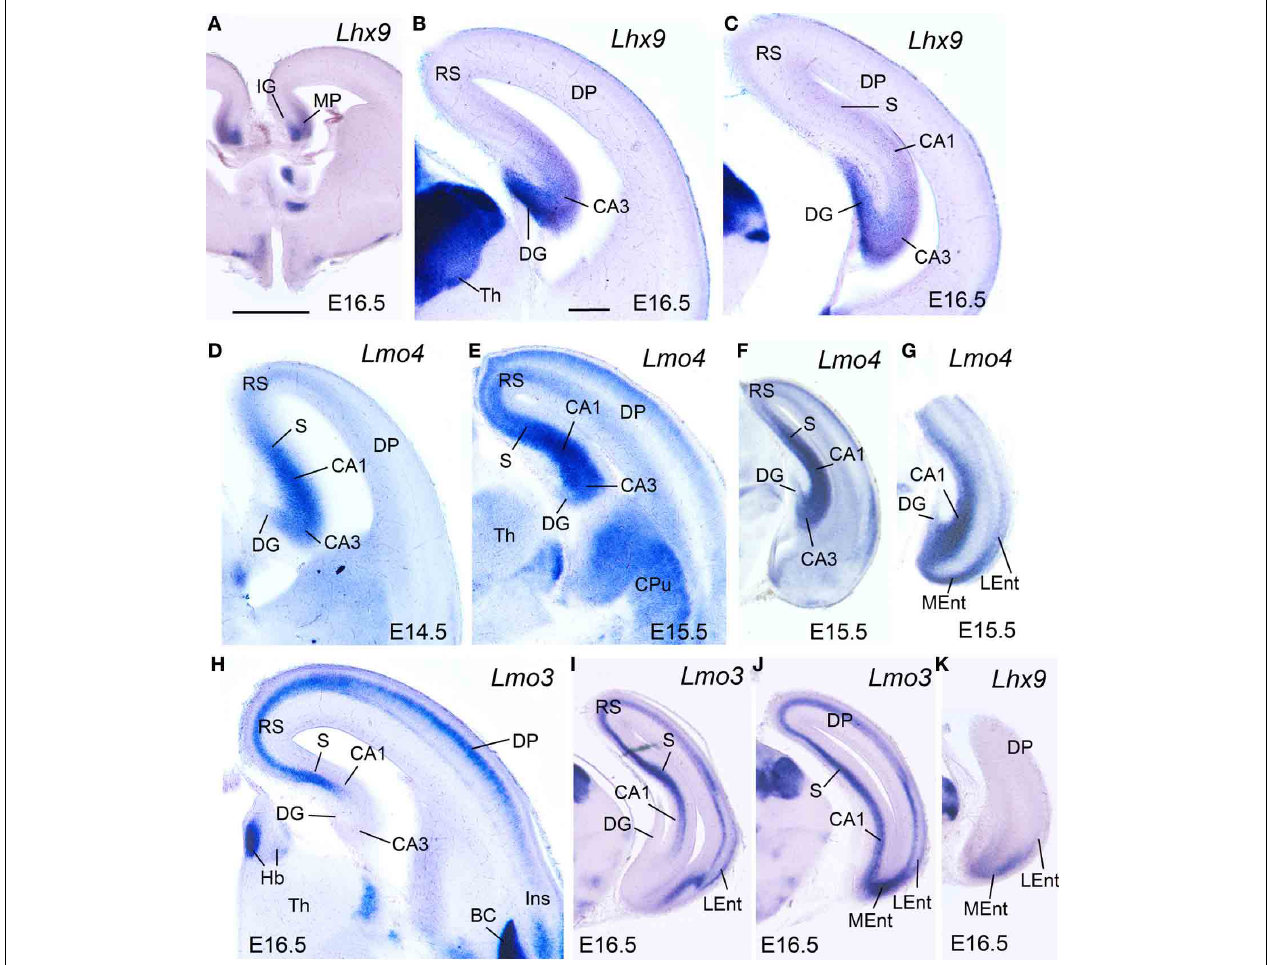
FIGURE 4 | Expression of Lhx9, Lmo3, and Lmo4 in mouse embryonic telencephalon at intermediate stages. Digital images of coronal sections of mouse embryonic telencephalon (E15.5 or E16.5), at intermediate (A–E,H) or